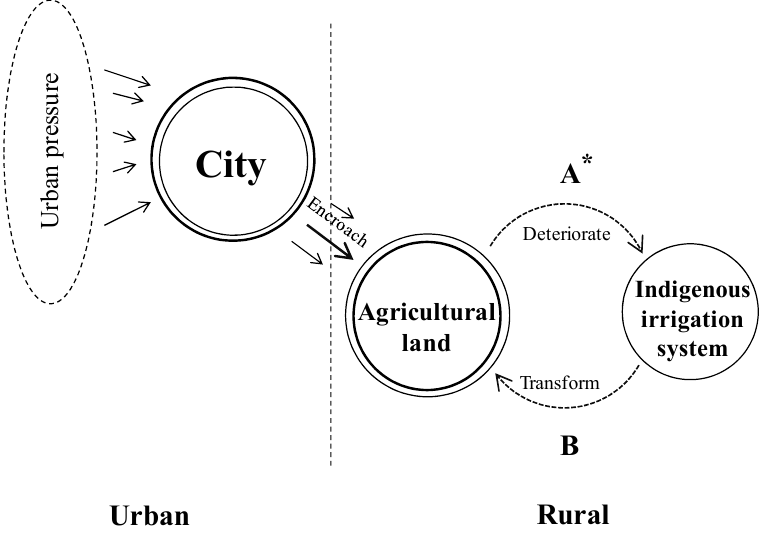
Figure 2. Diagram of urbanization processes in BMR’s peri-urban area. ( A* ) Urbanization on agricultural land induces irrigation system deterioration (main discussion issue of this paper); ( B ) Irrigation system deterioration induces urbanization on agricultural